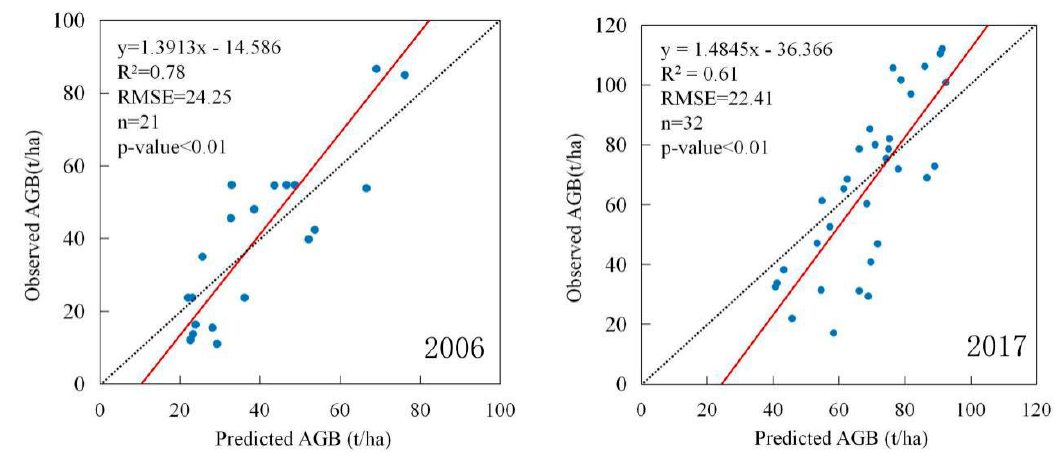
Figure 9. Relationship between the predicted and observed AGB values for the test samples with the random forest model. Table 8. Summary of the predicted biomass for the entire study area in 2006 and 2017.